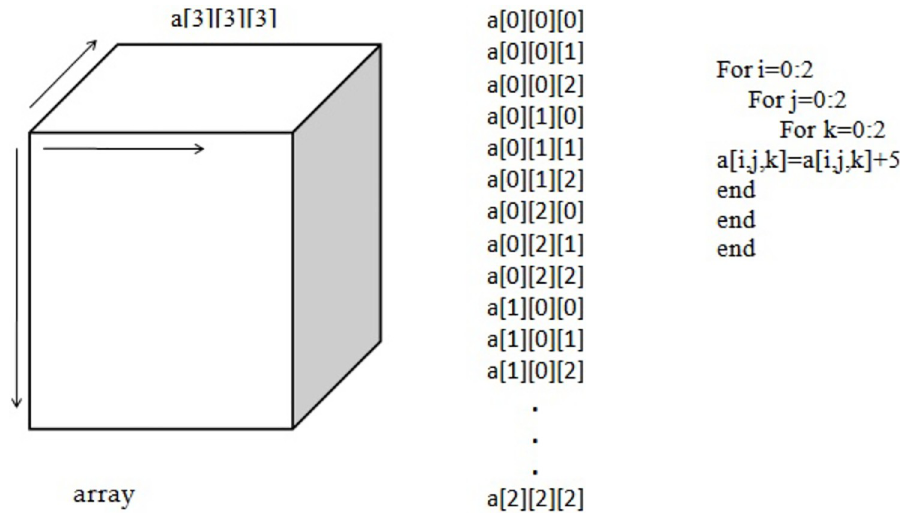
Fig 4. Three-dimensional